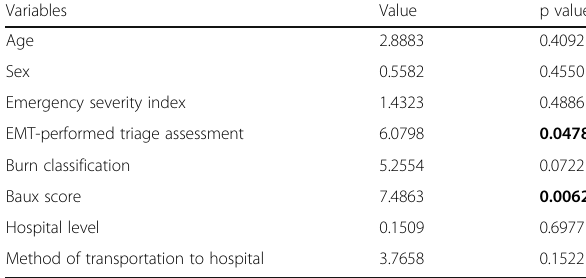
Table 1 (abstract 000070). Correlation between patient survival and study